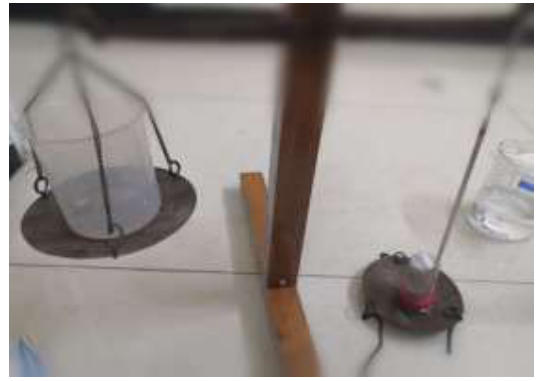
Figure 1. Mucoadhesive force modified balance method.